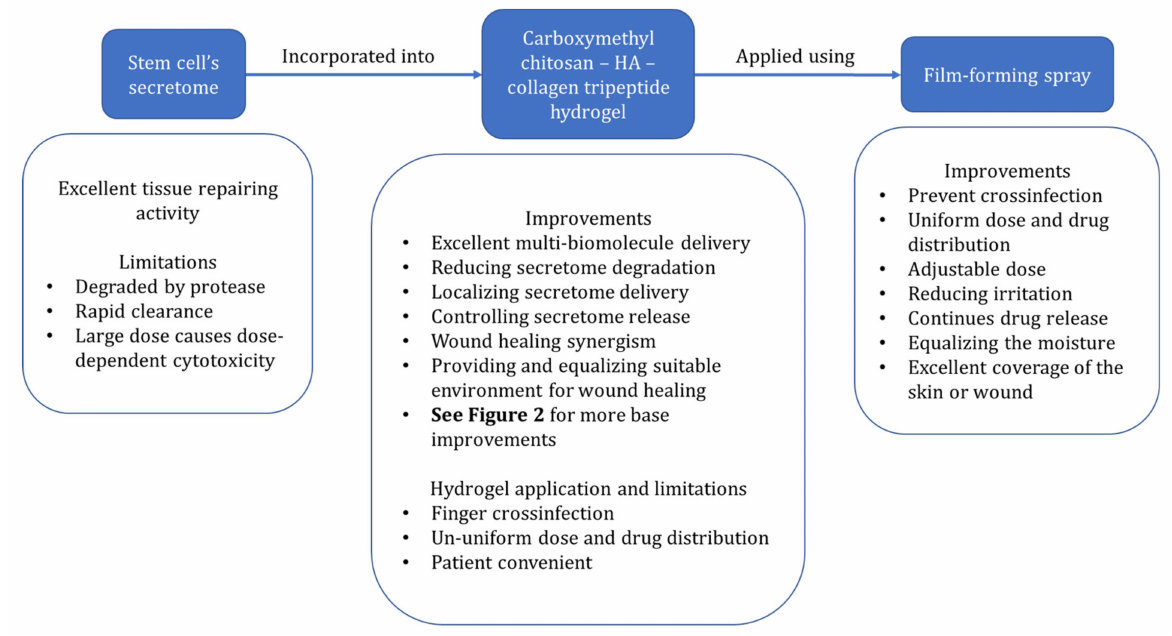
Figure 1. The framework of